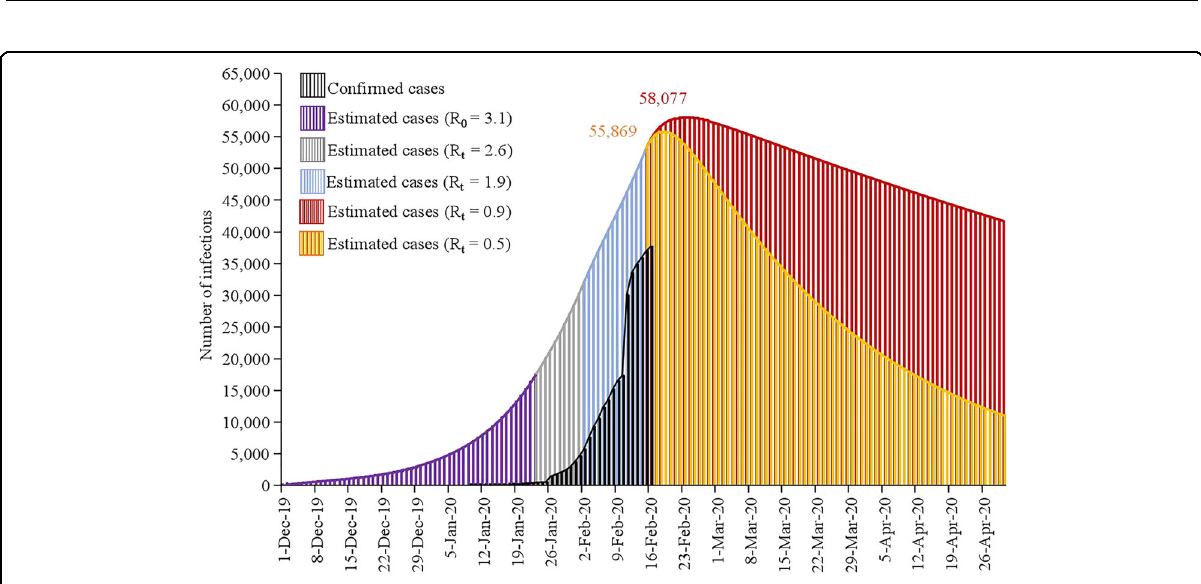
Fig. 2 Phase-adjusted estimation of the number of COVID-19 cases in Wuhan, China (1 December 2019 – 30 April 2020, E = 20I). In all, 55,869 represents the estimated peak number of COVID-19 cases on 19 February 2020 in Wuhan, China with R 0 = 0.5; 58,077 represents the estimated peak number of COVID-19 cases on 23 February 2020 in Wuhan, China with R 0 = 0.9; E : number of exposed cases; I : number of infectious cases; E was assumed to be 20 times of I at baseline.